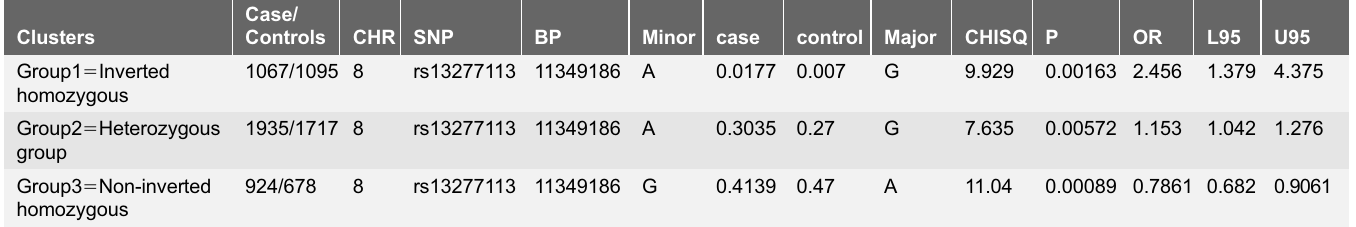
Table 2. Association and comparisons of minor allele frequency of known SNP rs13277113 for lupus according to three identified Caucasian subgroups. Case/ Clusters Controls CHR